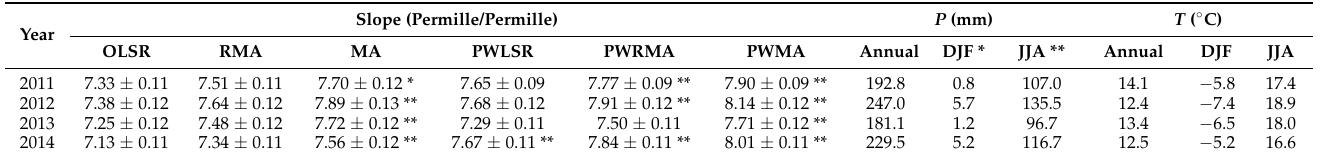
Table 1. Inter-annual variation of the slope of the δ D– δ 18 O linear relationship (in permille/permille) using the six regression methods, as well as the annual, December–January–February (DJF) and June–July–August (JJA) precipitation amount ( P in mm) and air temperature ( T in ◦ C) using event-based samples for all stations in Lanzhou from 2011 to 2014. Slope (Permille/Permille) P (mm) T ( ◦ C) Year OLSR RMA